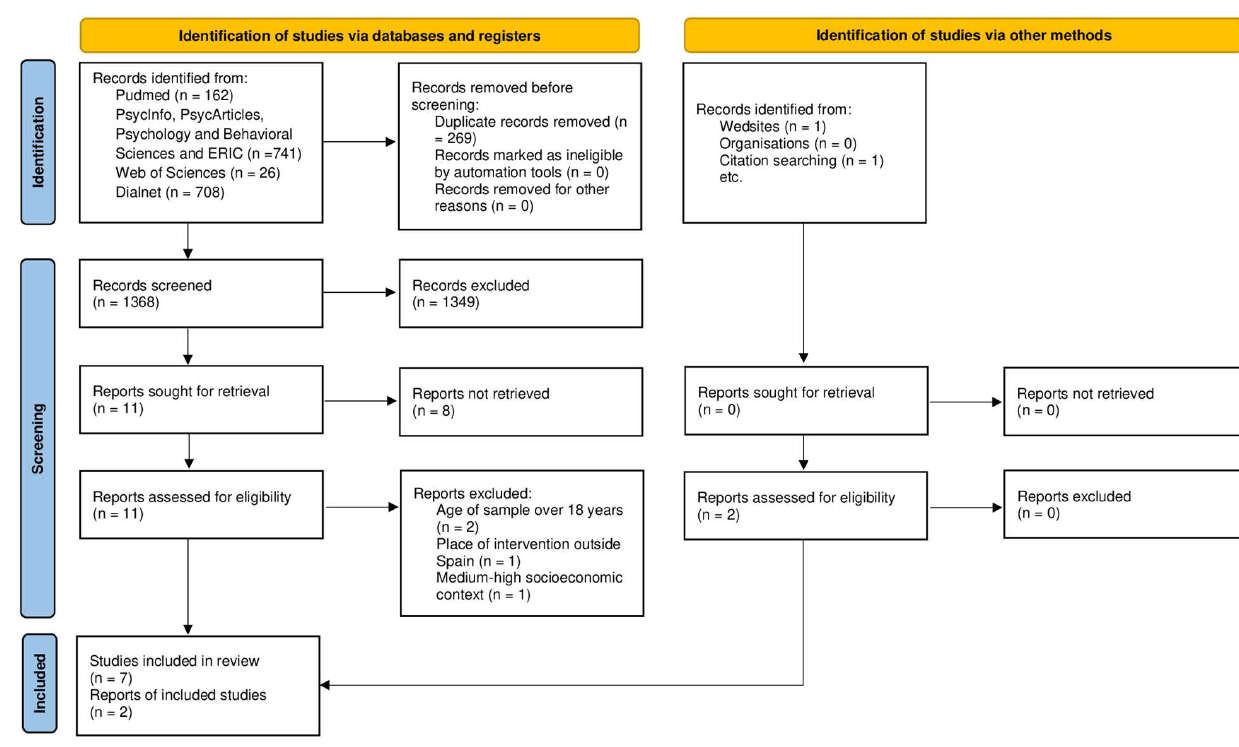
Figure 1. Search flowchart and selection process .